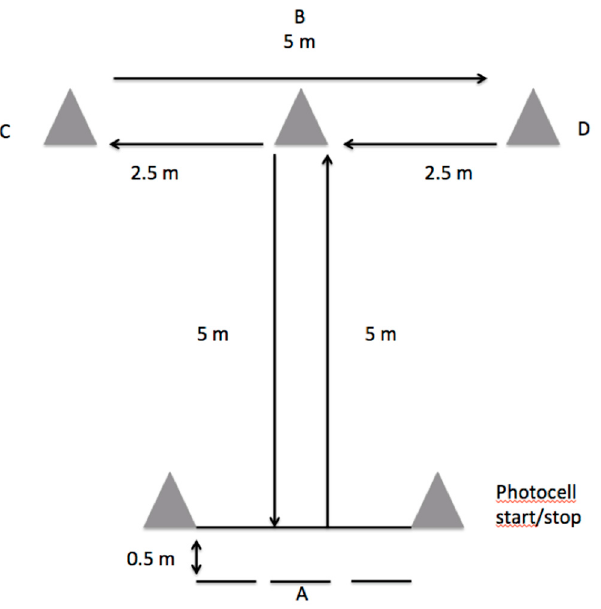
Figure 1. Modified agility test (MAT) test design.